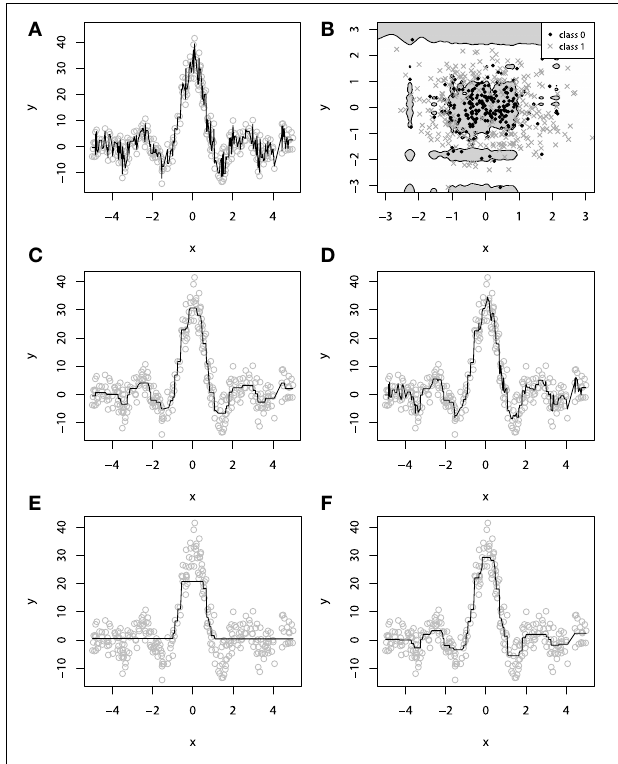
FIGURE 4 | Examples of overfitting in GBMs on: (A) regression task; (B) classification task. Demonstration of fitting a decision-tree GBM to a noisy sinc(x) data: (C) M = 100, λ = 1; (D) M = 1000, λ = 1; (E) M = 100, λ = 0 . 1; (F) M = 1000, λ = 0 .